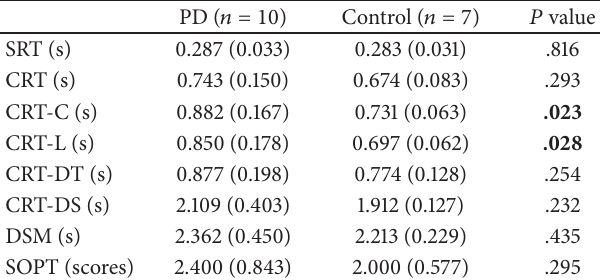
Table 4: Computerized cognitive measures for the PD and control